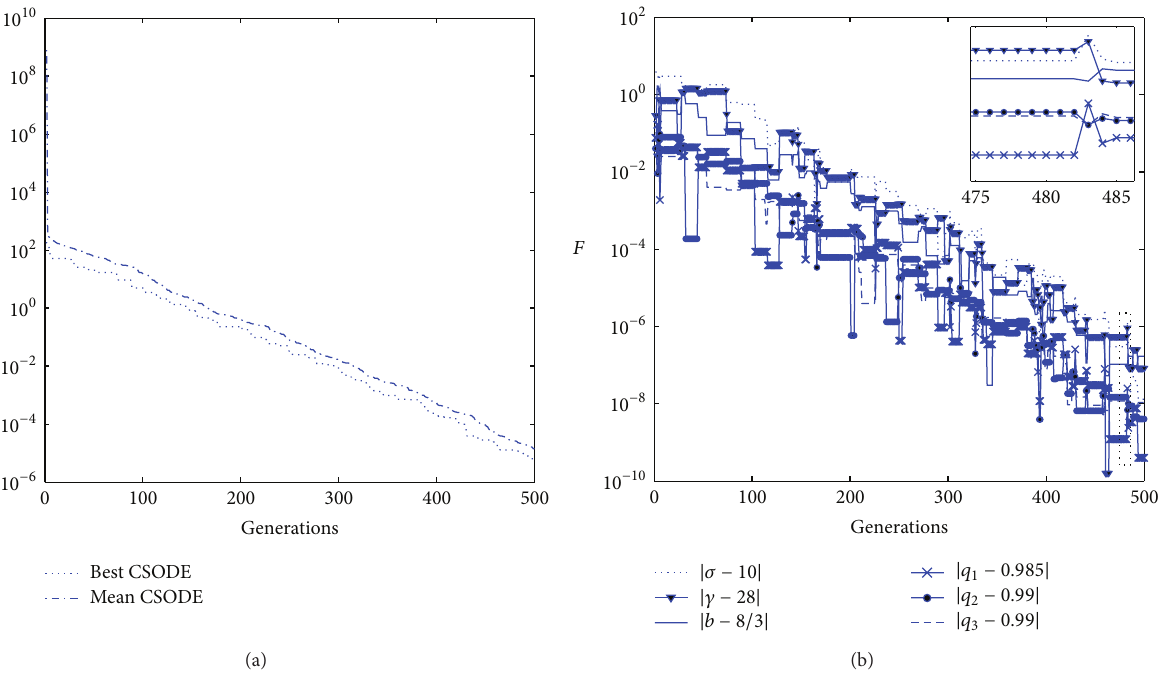
Figure 3: Evolution process for fractional-order Lor´enz system.